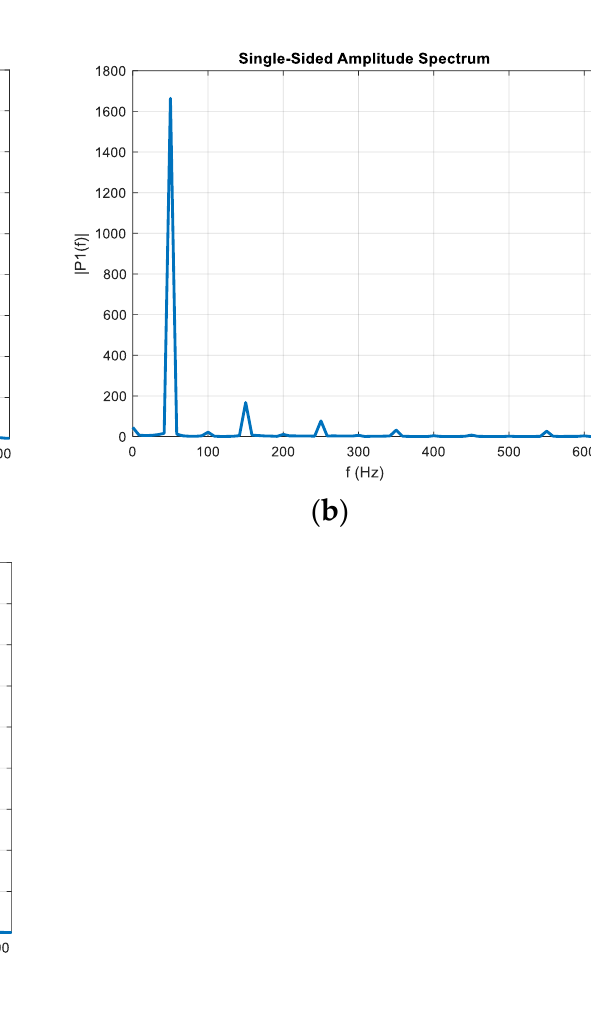
18 of 21 Figure 15. Harmonic distortion of the currents phase A: ( a ) without controlled choke (THD = 0.2 %) ( b ) with combined control MTVR when switched angel of thyristor is maximum 100°, which corresponds to the complete intro of the choke in the circle (THD = 0.7 %). Figure 16 shows the harmonic spectrum of mains currents (phase A, B, C) with current regulation of the choke at the beginning of the perturbation, when the maximum